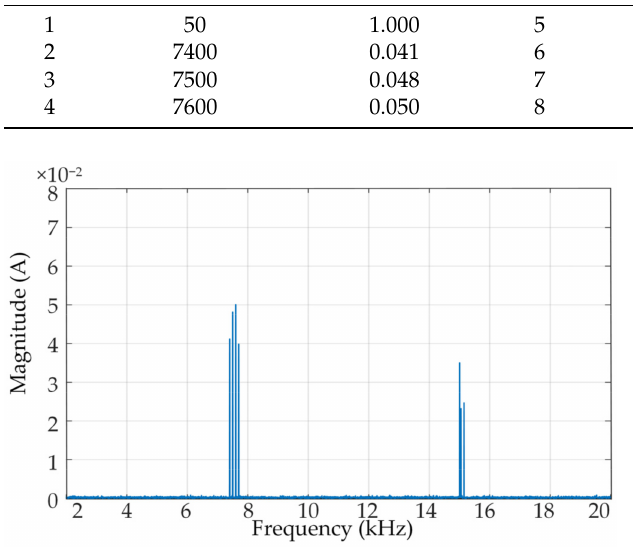
Figure 3. The spectrum of the synthetic signal.